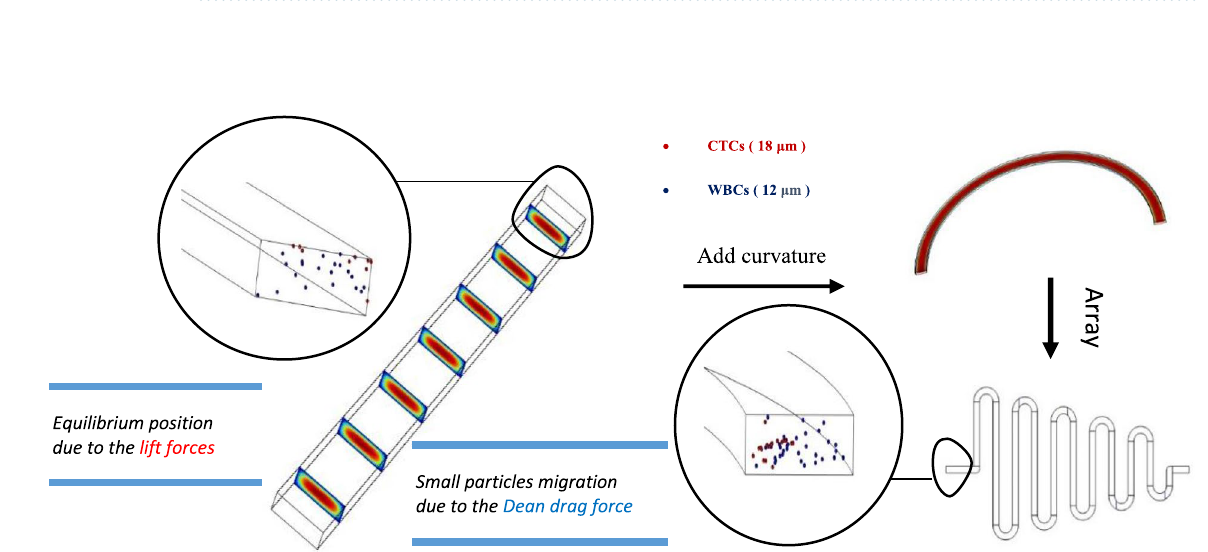
Figure 4. The results simulated in COMSOL software; at first, particles were traced in a straight microchannel, then curvature was gradually added to the microchannel and showed that due to the secondary dean flow, smaller particles began to migrate toward the outer wall. Finally, an array of these curved pieces was formed. Red particles are 18 µm, and blue particles are 12 µm in diameter. These particles mimic the behavior of WBCs and CTCs, respectively (COMSOL Multiphysics ® Version 6.0 is available: https:// www. comsol. com/ relea